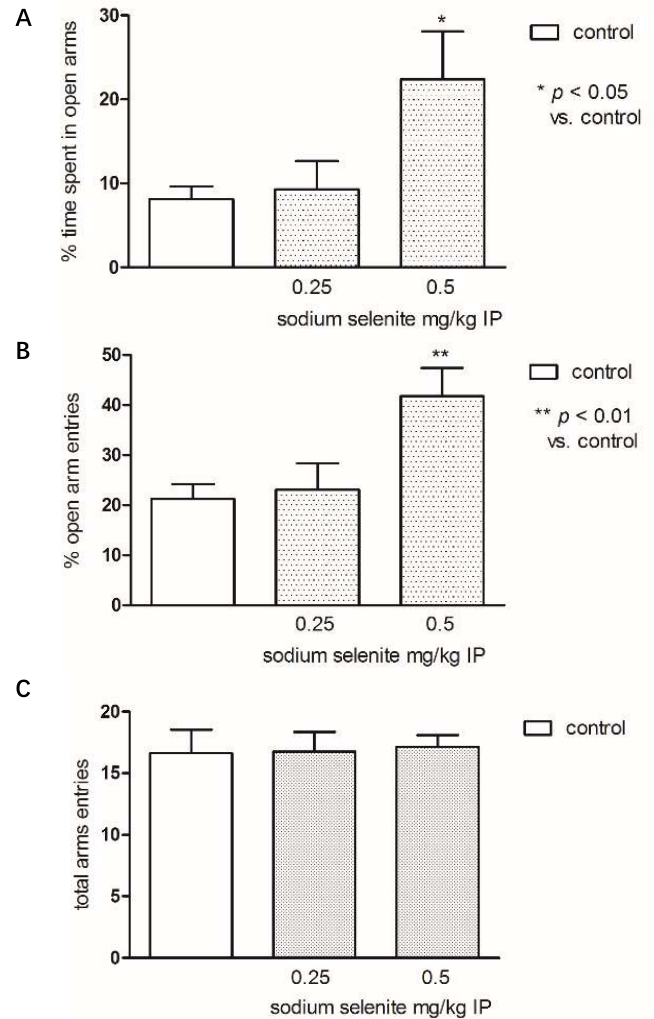
Figure 7 . The effects of sodium selenite (at the doses 0.25 and 0.5 mg/kg) on the percentage of time spent in open arms: ( A ) percentage of open arm entries and ( B ) total number of arm entries ( C ) in the elevated plus-maze (EPM) procedure. Sodium selenite was administered IP 30 min before the test. Data are expressed as mean ± SEM values. ** p < 0.01; * p < 0.05 vs. control vehicle-treated group (Bonferroni’s test).